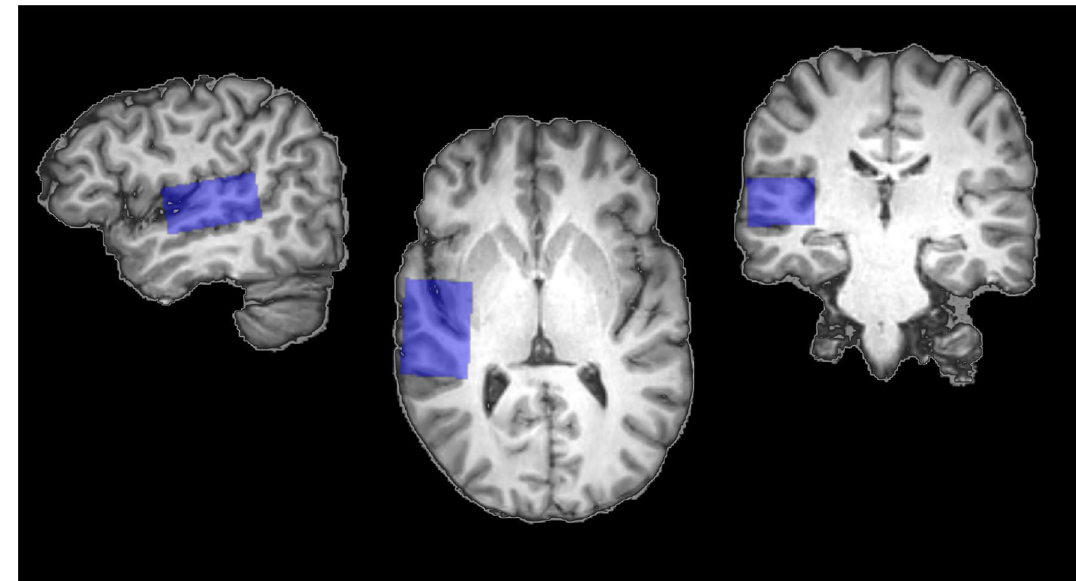
Figure 1. MRS ROI voxel. Right voxel (radiological convention) colored in blue and in sagittal, horizontal, and coronal view (from left to right). The voxel covers Heschl’s Gyrus, parts of superior temporal gyrus, and insular cortex. No differences in voxel size or composition between the two hemispheres were